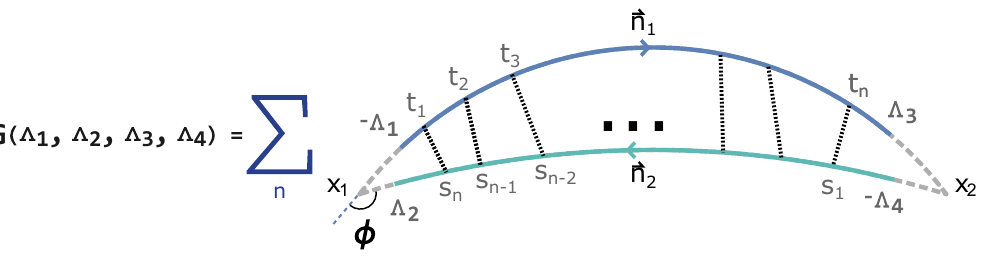
Figure 3 . The two cusp correlator with four di(cid:11)erent cut-o(cid:11)s (cid:3) a , which can be considered as a particular case of 4-cusp correlator. We take n points along each of the circular arcs and connect them with scalar propagators. We have to integrate over the domain (cid:0) (cid:3) 1 < t 1 < t 2 < (cid:1) (cid:1) (cid:1) < t n < (cid:3) 3 and (cid:0) (cid:3) 4 < s 1 < s 2 < : : : s n < (cid:3) 2 . One should use a speci(cid:12)c parameterization given in